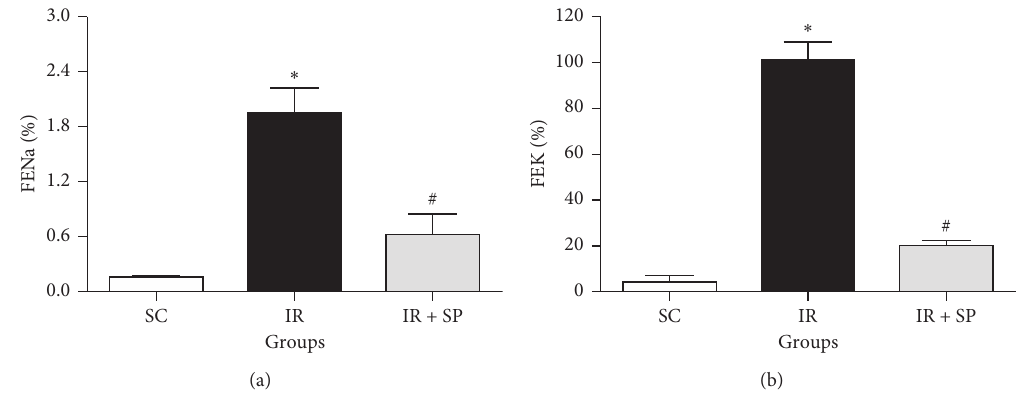
Figure 2: Effect of SP extract on FENa (a) and FEK (b) following I/R injury. Data are shown as mean ± SEM. ∗ Significant against the SC group ( P < 0 . 05); # significant against the IR rats ( P < 0 . 05). SC: sham control; SP : Stachys pilifera ; I/R: ischemia-reperfusion; FENa: fractional